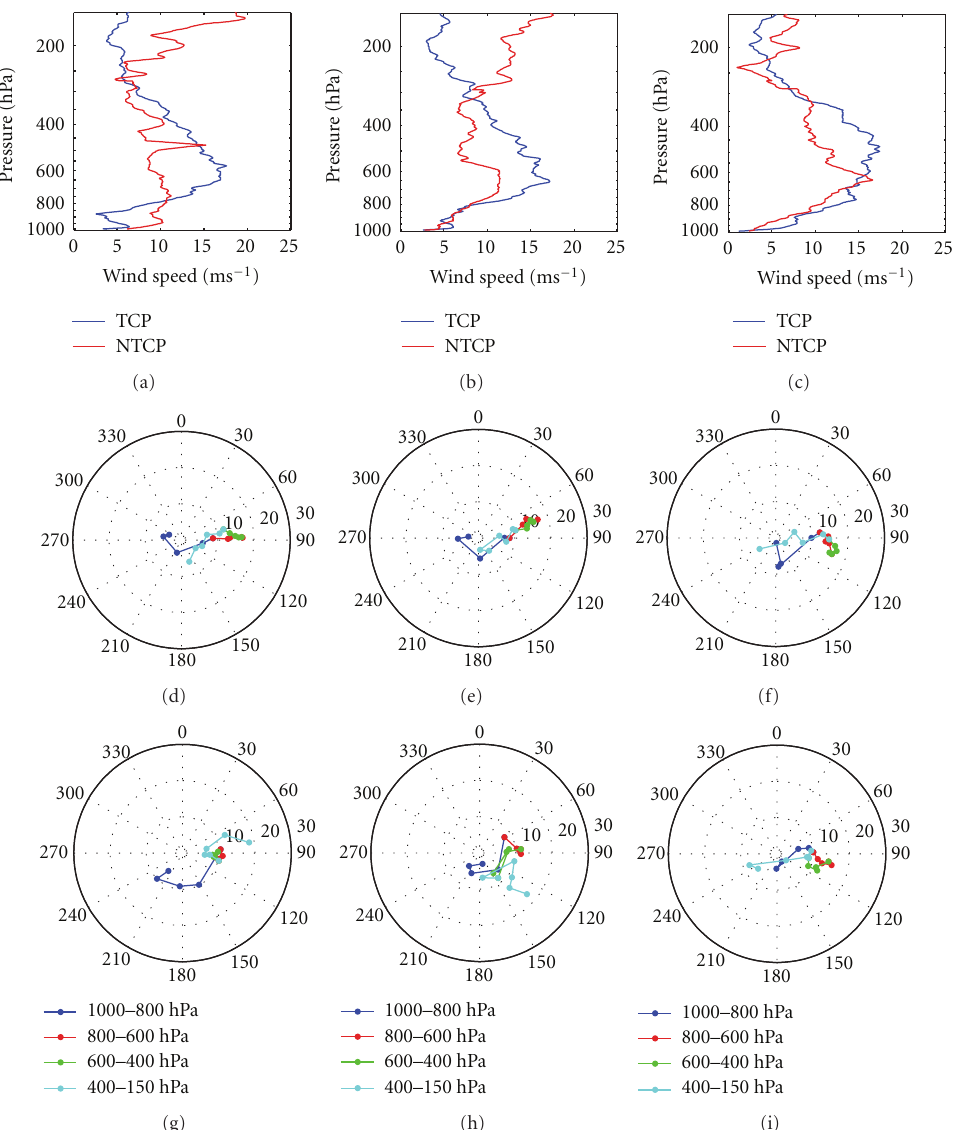
Figure 9: Vertical profiles of wind speed (ms − 1 ) are shown in panels labeled (a), (b), and (c) with the mean TCP case represented by the solid blue line. Corresponding hodographs of the mean TCP case are shown in (d), (e), and (f) and for the mean NTCP case in (g), (h), and (i). The colors in the hodographs are 1000–800 hPa (dark blue), 800–600 hPa (red), 600–400 hPa (green), and 400–150 hPa (cyan). Points increment every 50hPa on the